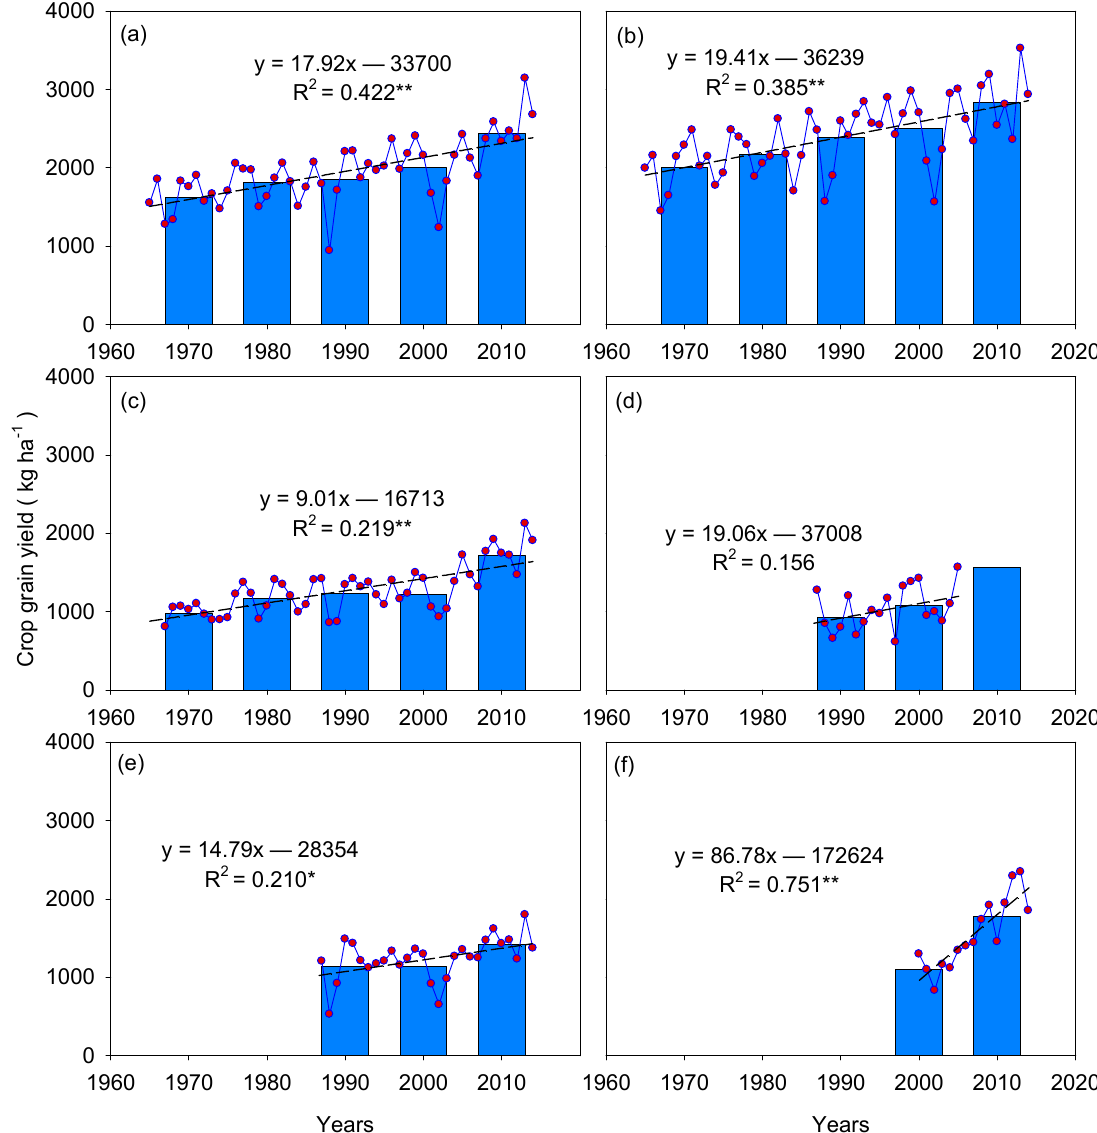
Figure 4. Variations of grain yields for six crops in Saskatchewan. The solid circles show the annual grain yields and the bars show the decadal average grain yields from 1965 to 2014. ( a ) spring wheat; ( b ) barley; ( c ) canola; ( d ) sunflower; ( e ) lentil; ( f ) chickpea. Note. * Significant difference at the 0.05 level; ** significant difference at the 0.01 level.